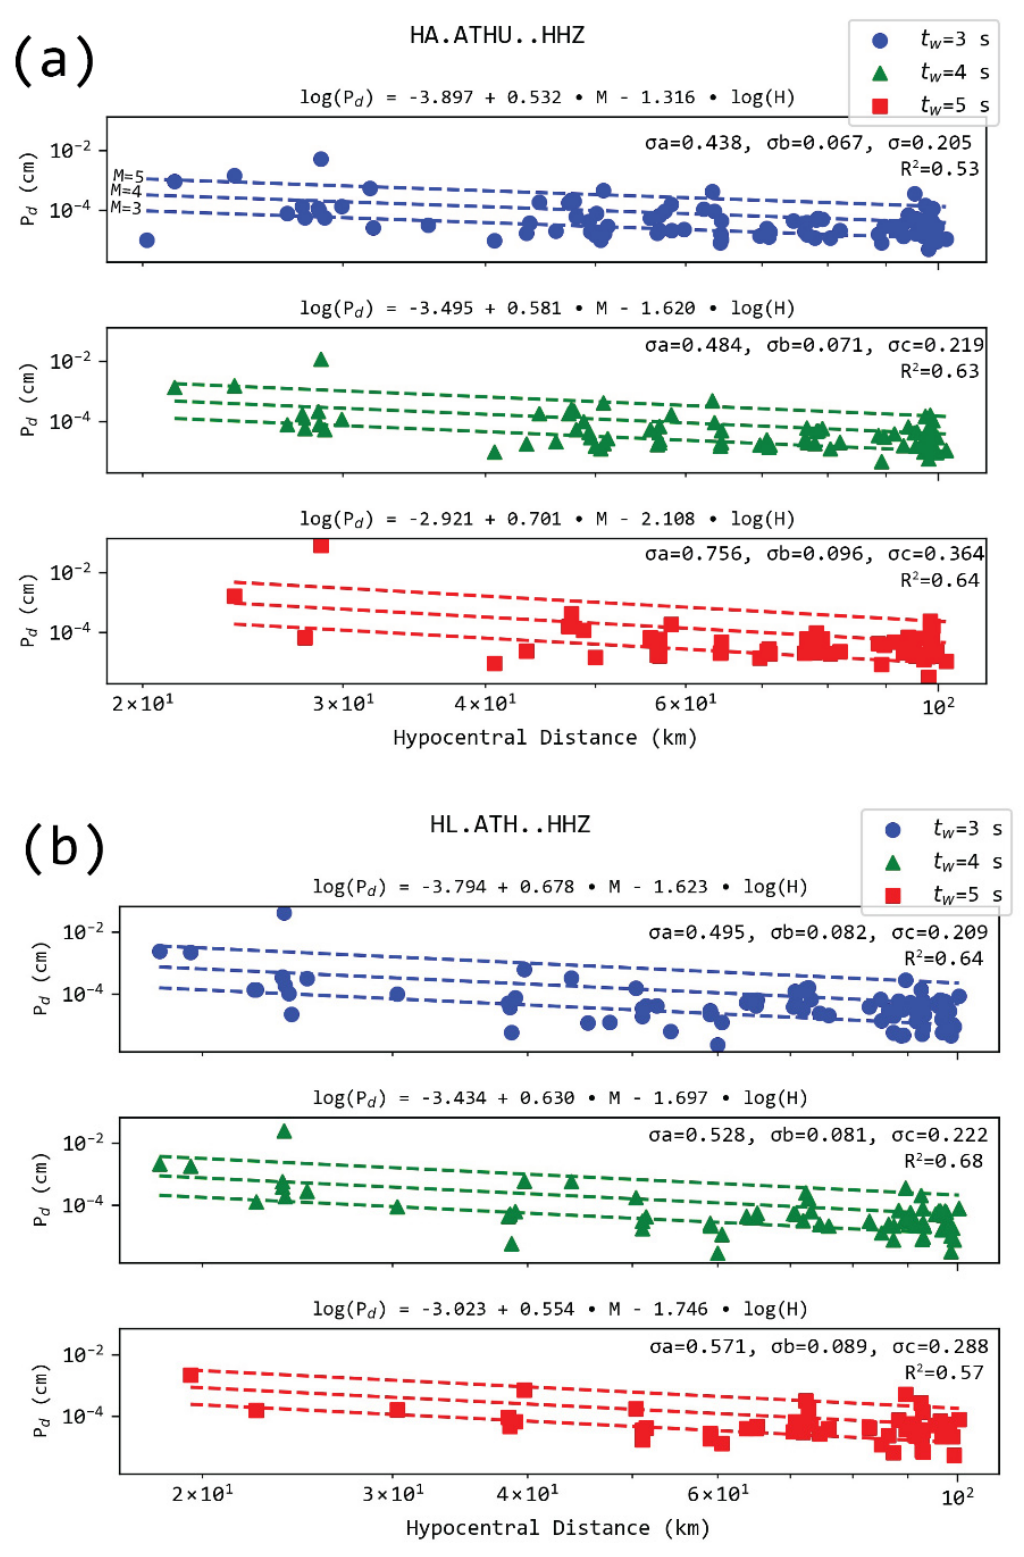
Figure 4. Regression analysis for P d measured in two stations located in Athens stations. ( a ) for ATHU and ( b ) for ATH and for 3 s (top), 4 s (middle), and 5 s (bottom) from the P arrival. The dashed lines show the model for M = 3.0, M = 4.0, and M = 5.0. σ a: s.d. for the intercept, σ b: standard deviation for the magnitude variable’s constant (M), σ c: s.d. for the hypocentral distance (H) variable’s factor, and R 2 the squared correlation coefficient for the regression.